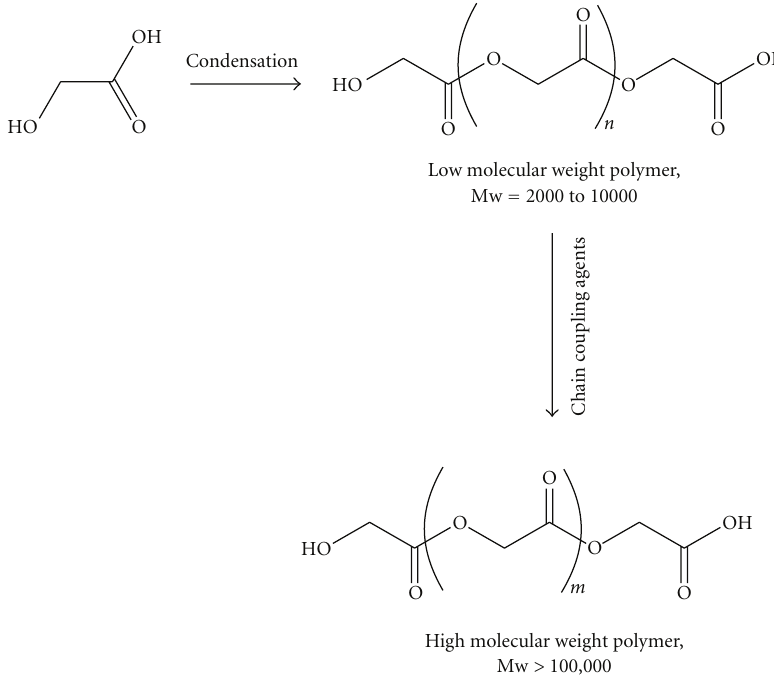
Scheme 13: General scheme for oligomer synthesis and chain coupling reaction for polyhydroxyesters.